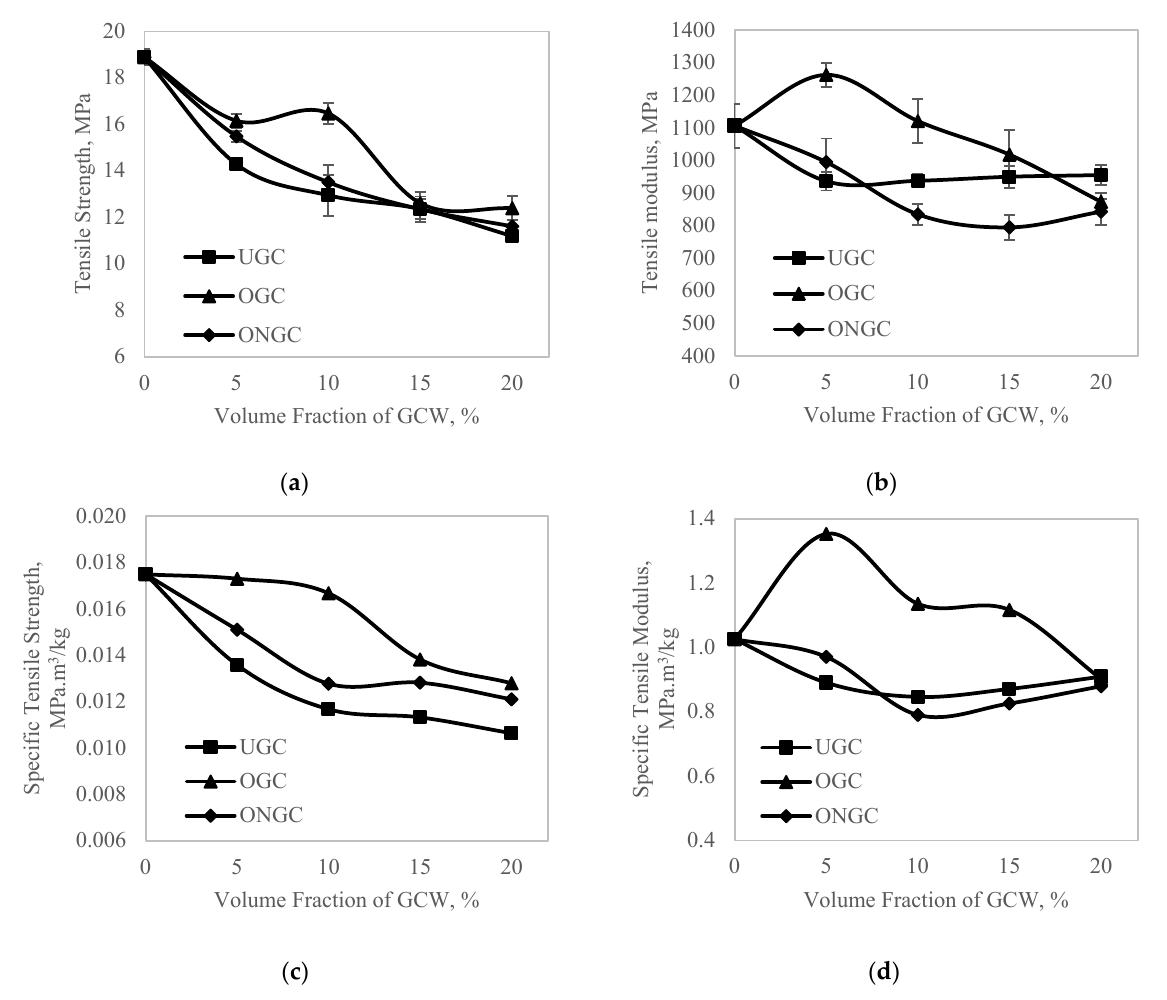
Figure 5. ( a ) Tensile Strength ( b ) Tensile Modulus ( c ) Specific Tensile Strength ( d ) Specific Tensile Modulus of HDPE, UGC, OGC and ONGC of different particle loadings.